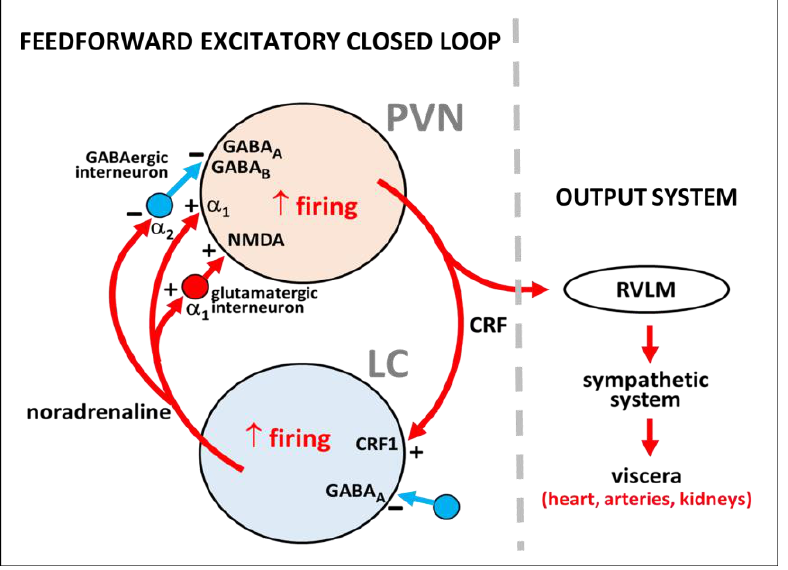
Figure 2. Summary of local regulatory neural circuits in the PVN-LC network considering the role of interneurons in the PVN and the LC according to the literature. A CRF-expressing neuron of the PVN and a noradrenaline-synthesizing neuron of the LC are represented, showing α 1 and α 2 receptors for noradrenaline, GABA A and GABA B receptors for γ -aminobutyric acid, NMDA receptor for glutamate, and CRF 1 receptor for CRF. Excitation or inhibition are indicated by the plus (+) and minus ( − ) signs, respectively. The output system to viscera is shown. RVLM, rostral ventrolateral medulla.